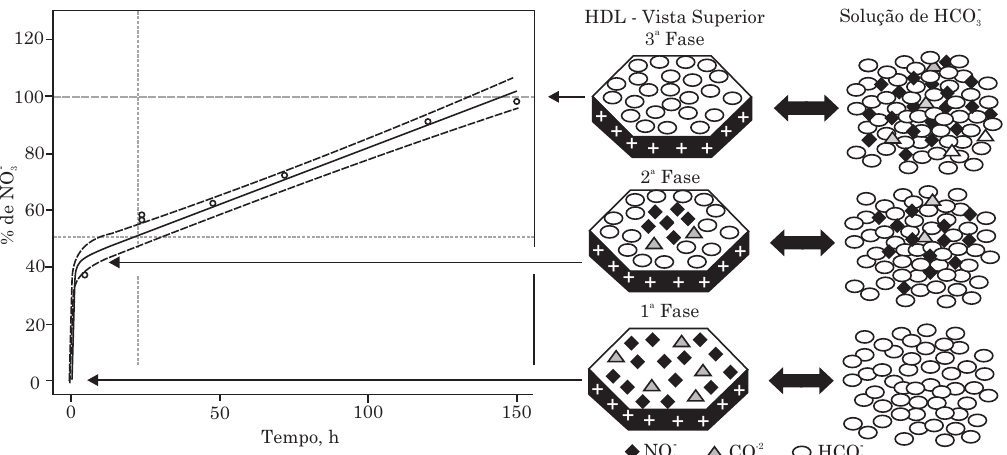
Figura 4. Representação das trocas aniônicas de arestas e regiões periféricas dos cristais e surgimento do efeito chamado “barreira iônica interlamelar” (2ª